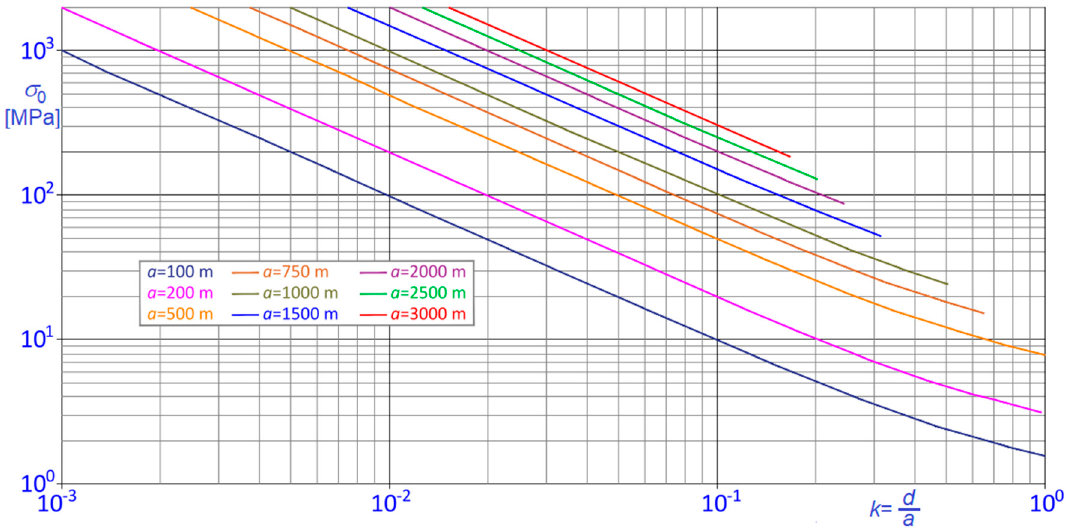
Figure 8. σ 0 − k curves for steel cables, parameterized in terms of chord length, a . Figure 8. 𝜎 (cid:2868) − 𝑘 curves for steel cables, parameterized in terms of chord length , 𝑎 .